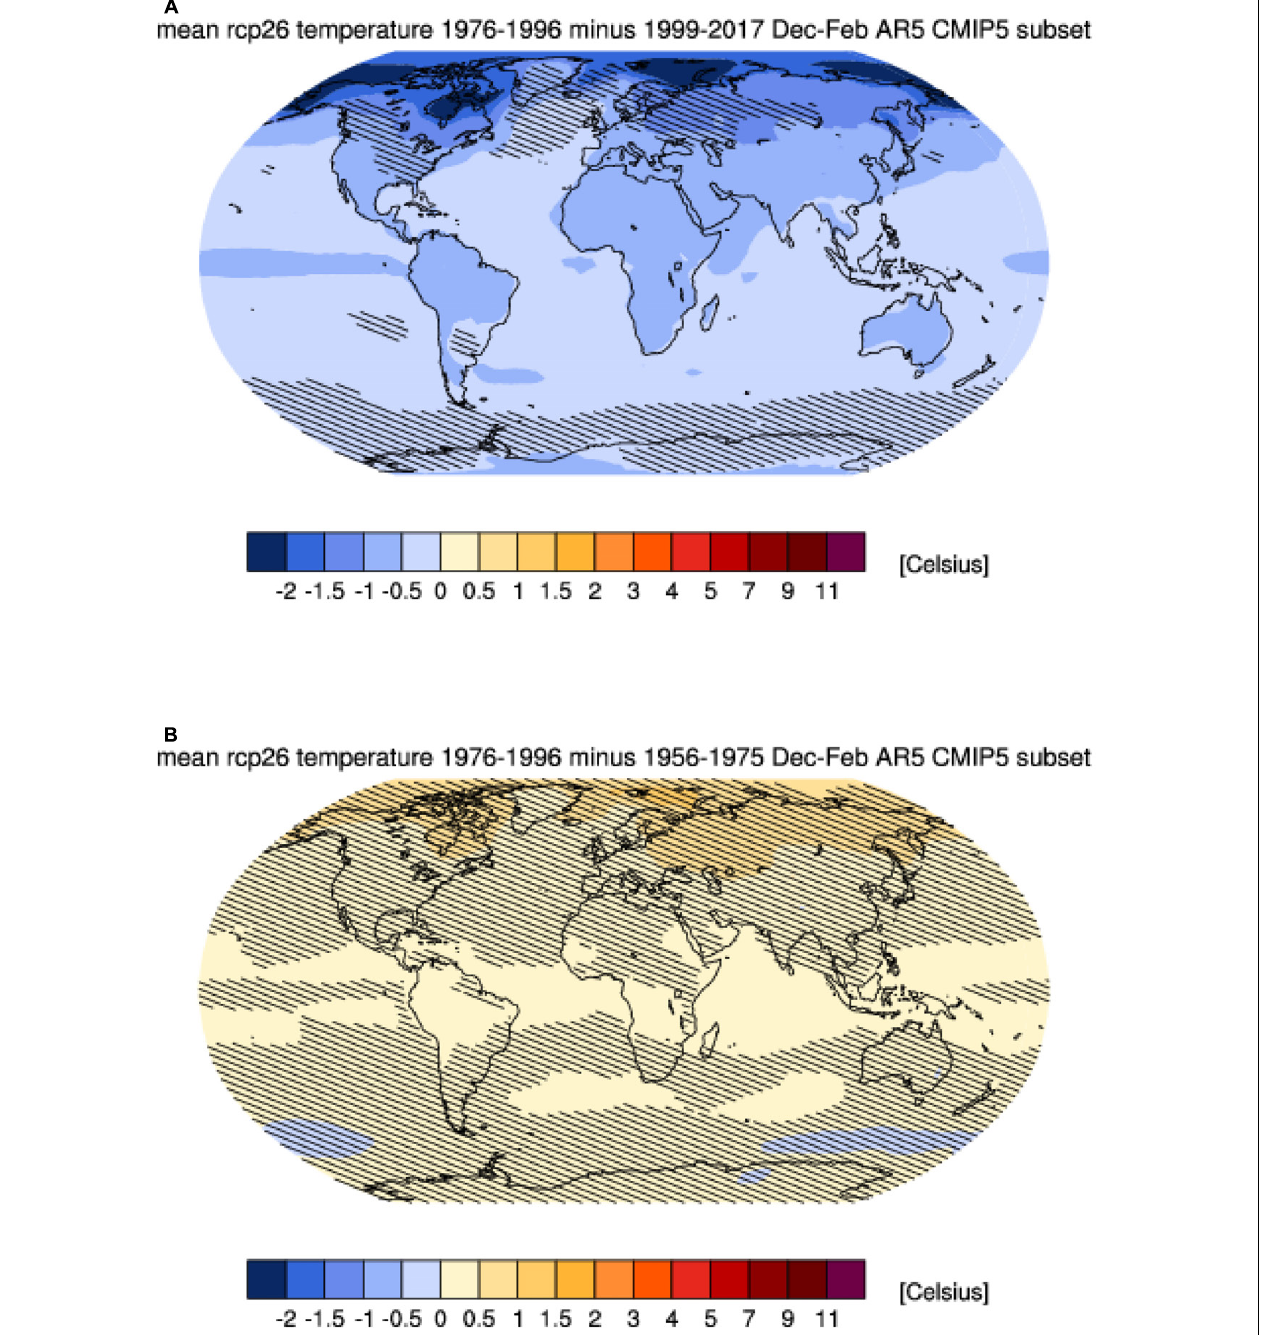
FIGURE 4 | Mean temperature anomaly (Dec-Feb) for 1976–1996 with respect to reference level (A) 1999–2017 and (B) 1956–1975 considering AR5 CMIP5 subset models ensemble. Plots are generated using the IPCC’s Climate Change Atlas, climexp.knmi.nl/plot _atlas _form.py. Signal smaller than one standard deviation of natural variability is shown by